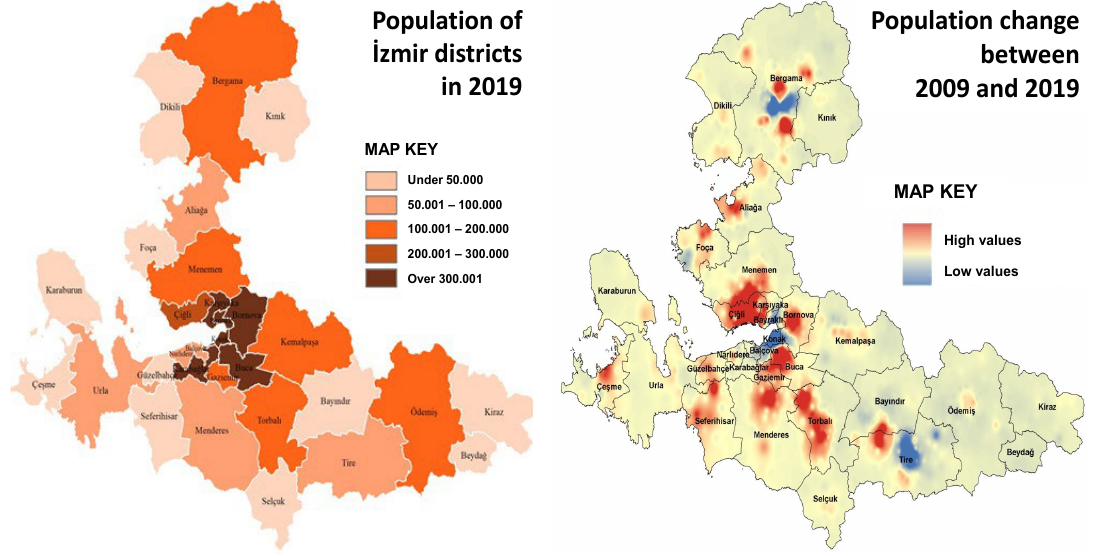
Figure 1 Population of İzmir districts in 2019 Figure 2 Agglomeration of population change